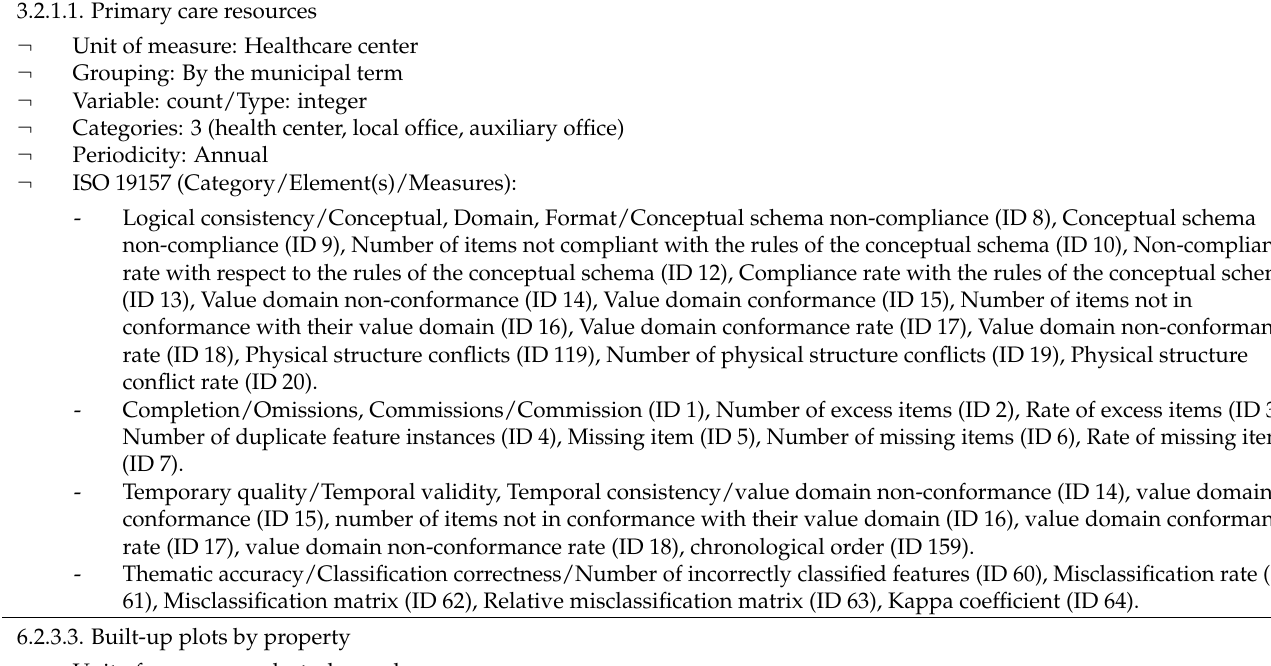
Table 3. Example of ISO 19157 data quality elements and measures (*) that can be applied to some SIMA